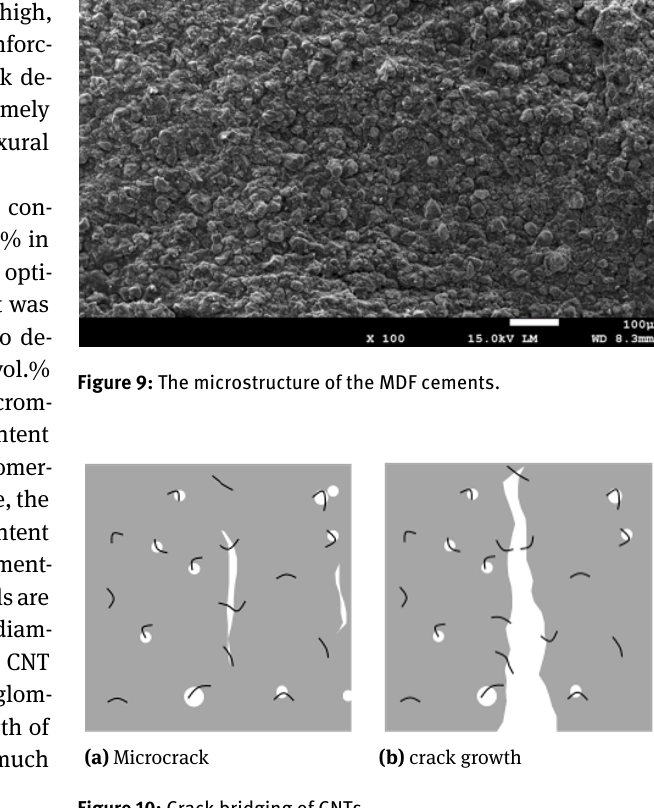
Figure 10: Crack bridging of